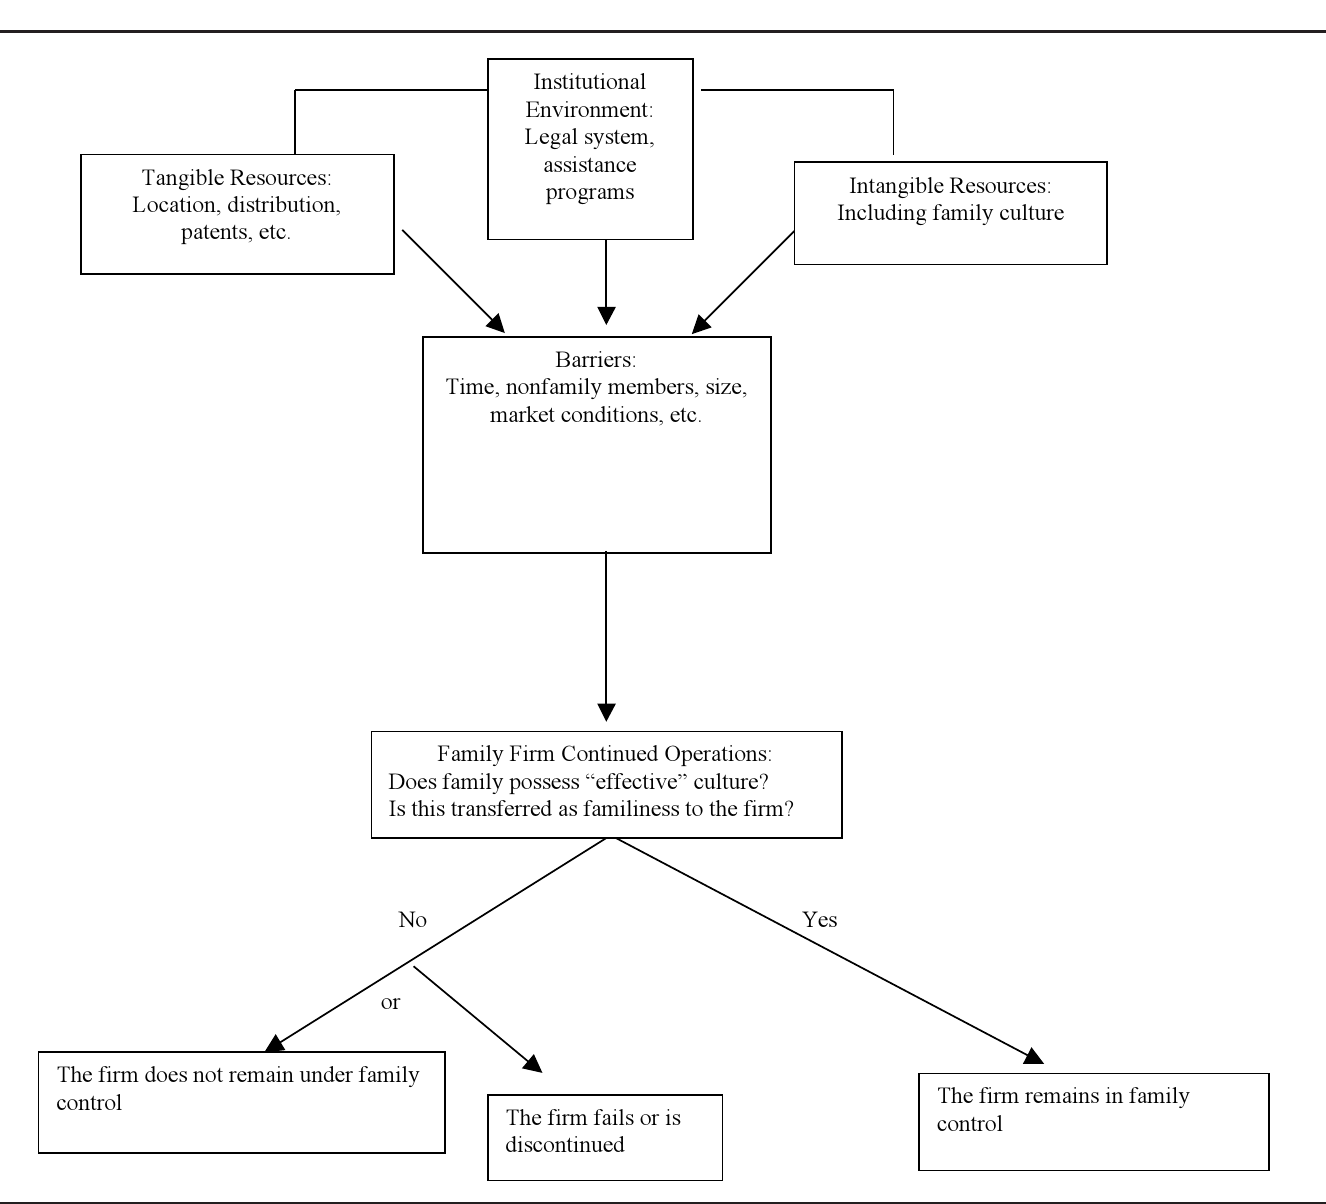
Figure 1. Family Culture, Familiness, and Succession in the Family